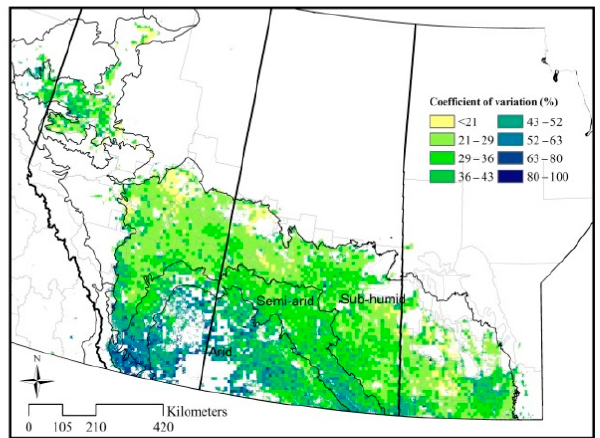
Figure 10. Spatial patterns of rainfall trends from 2000 to 2013 using the M–K z -score.